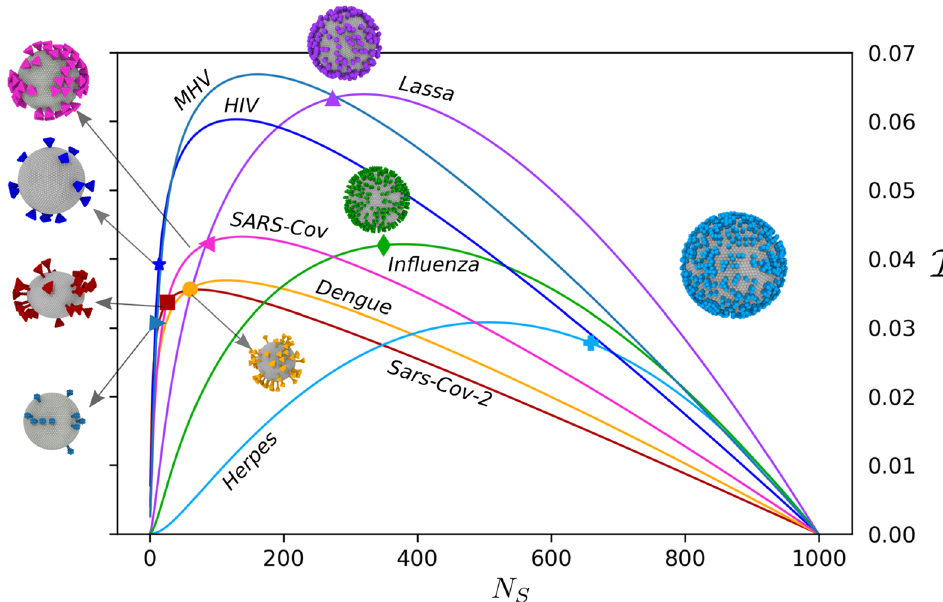
Figure 4. Interplay between virion rotational diffusion and receptor binding affinity for SARS-CoV-2 and selected viruses. The figure shows the variation in the infectivity parameter I with the number of surface proteins. The markers indicate the experimentally reported values of N s for each virion type, which in most cases matches well with the theoretical optimum value. HIV and MHV are two exception with particular low values of N s , perhaps related with enhanced mobility of S around the envelope, specific virus/mucus interactions, or an earlier reactive saturation requiring fewer S than N ∞ s due to strong binding affinities with their